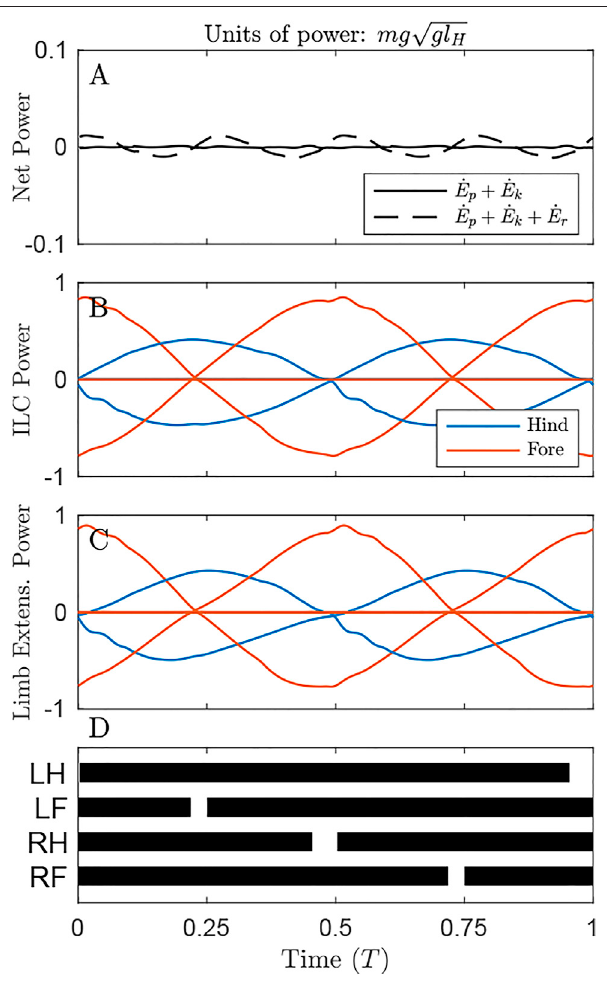
FIGURE 3 | Power through time for the solution minimizing Net COM Work, under the distributed mass model, showing the origination of cost under different metrics. (A) Net power on the COM remains zero throughout the cycle (solid line), but system energy fl uctuates slightly dueto pitching of the body (dash line) (B) Individual Limbs COM Power and (C) Limb extensionpowerarelarge,owingtosubstantialcompressionandextensionof the limbsdue to (D) largeduty factors asshown inthe gaitdiagram, leadingto long periods of quadruple stance. Here and in the gait diagrams of Figures 4 , 5 , stance is plotted when GRF exceeds 0.02 body weights for a given limb.